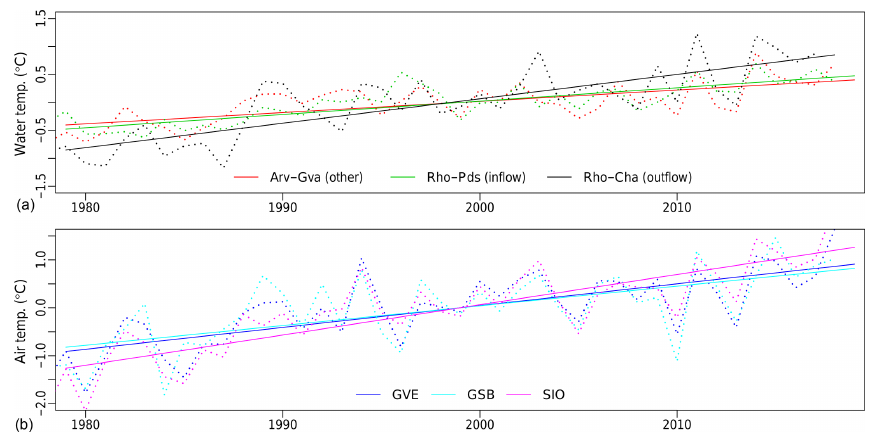
Figure 7. (a) Lake Geneva water temperature anomalies and trends for inflow (Rho-Pds) and outlet (Rho-Cha) stations (a) . Arv-GVA denotes the Arve in Geneva, Rho-Pds represents the Rhône in Porte du Scex, and Rho-Cha represents the Rhône in Chancy. (b) Air temperature anomalies and trends for surrounding MeteoSwiss stations. GVE denotes Geneva-Cointrin, GSB denotes Grand Saint-Bernard, and SIO denotes Sion. The period for trend computation is from 1979 to